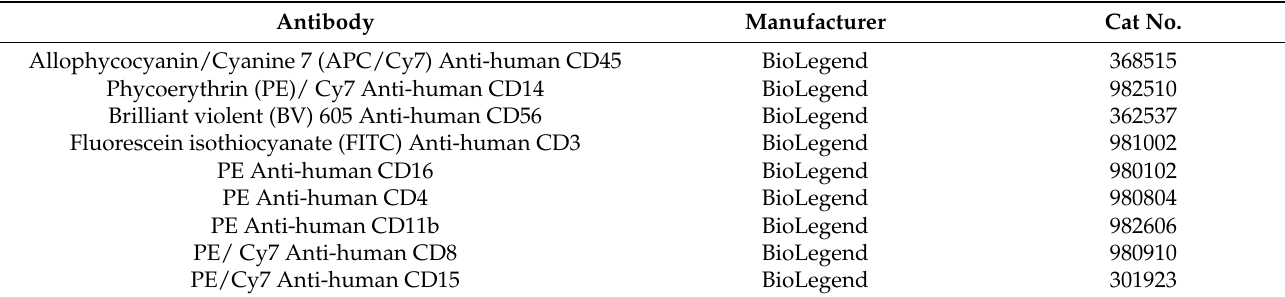
Table 2. Antibodies for Flow Cytometry.